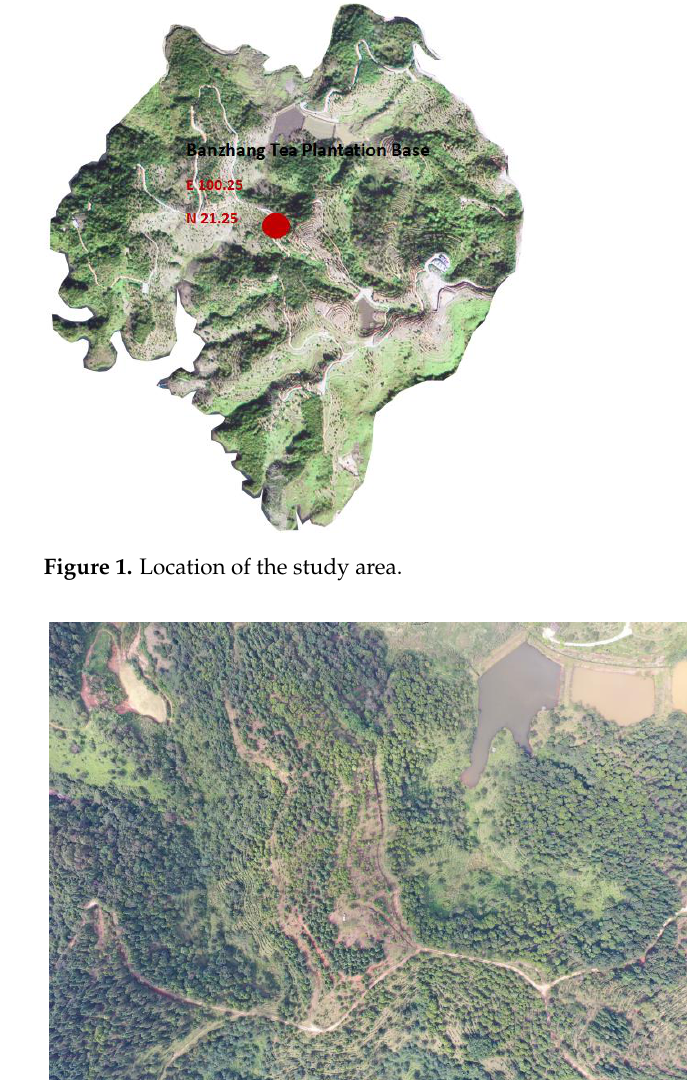
Figure 2. Tea plantation base picture with drones. One bud and two new leaves were collected from the top, middle, and bottom of the slope in each slope direction to make sun-baked tea, and each sampling area was repeated three times. The sun-baked tea was used to determine the biochemical composition and to evaluate the sensory quality of the tea leaves. The soil collection area was between the tea picking site, and the topsoil of 4–5 cm of the soil surface was excavated, and the soil of the cultivation layer within 20 cm deep was taken vertically. The soil sample numbers are shown in Table